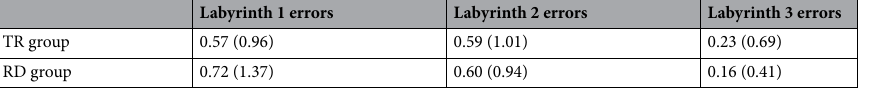
Table 3. Number of errors (mean and standard deviation) in the three labyrinths of children without (TR) and with reading difficulties